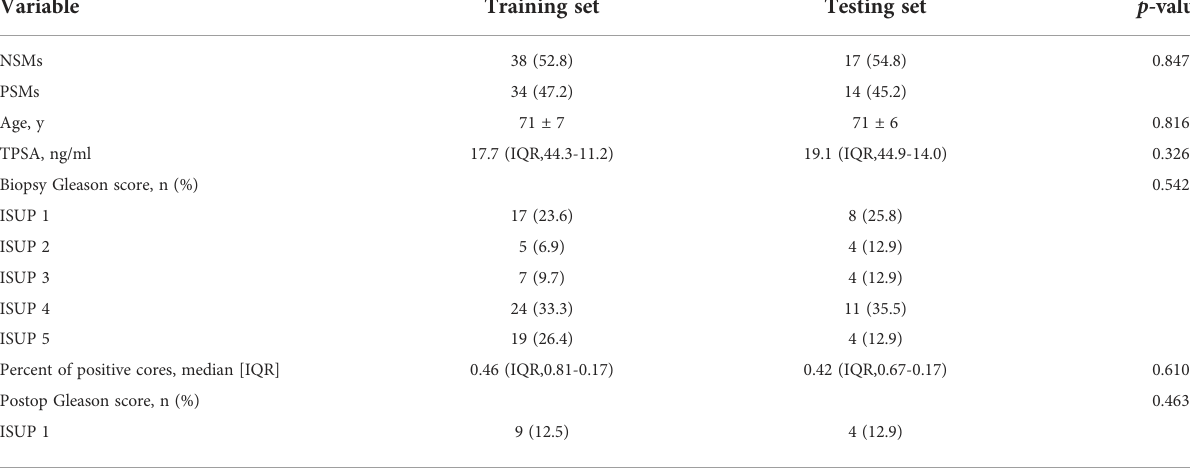
TABLE 3 Clinical characteristics of the training and testing sets for MRI nomogram predicting PSMs.